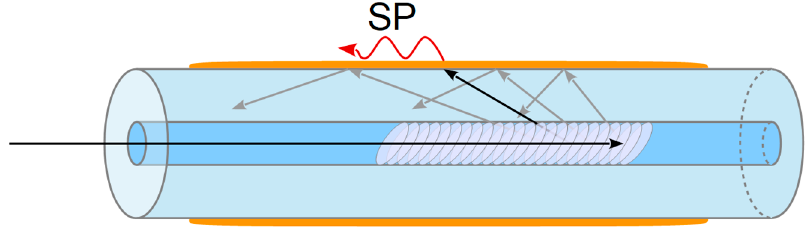
Figure 1. Scheme of an SPR fiber-based TFBG-assisted sensor.